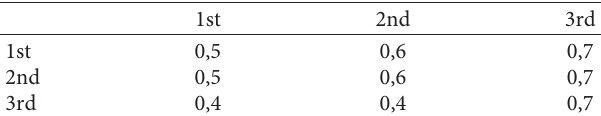
Figure 14: Obtained values of the comparison of the 3rd mobile object of the group of red with the robotic of blue and the identification of the most successful targeting. Table 4: The final decision on the appointment.